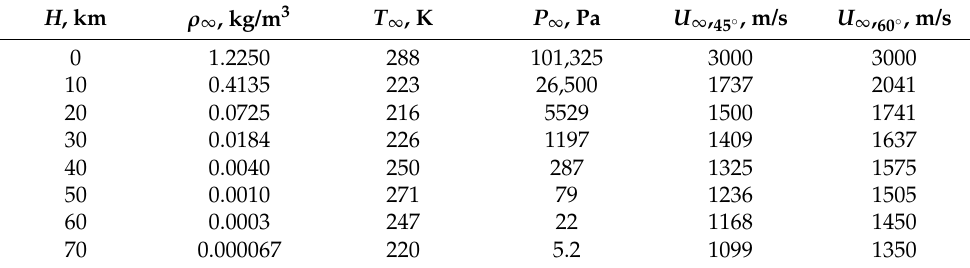
Table 3. Free stream conditions at representative